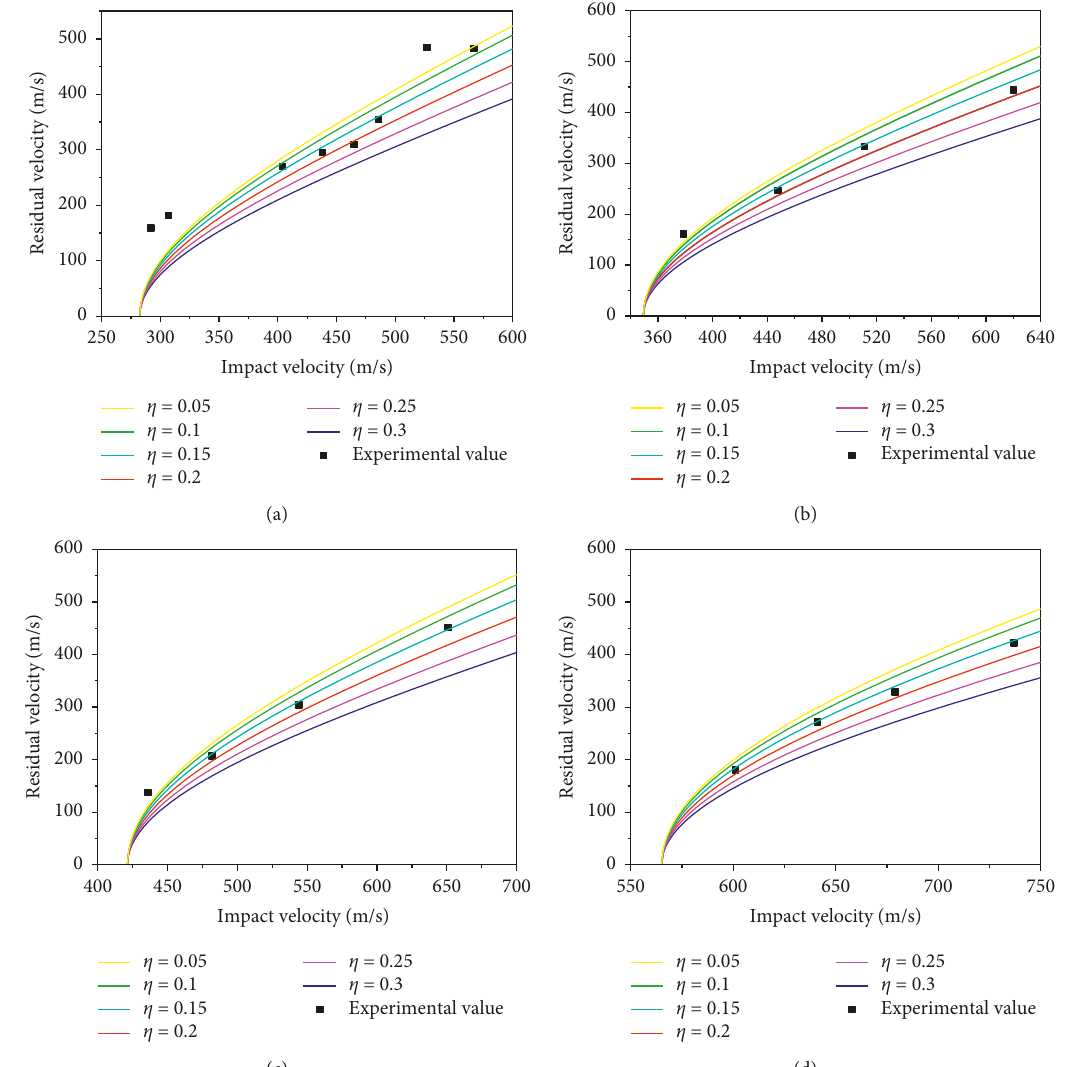
Figure 5: Comparison between calculated and experimental values of the projectile residual velocity for different concrete thicknesses. (a) 100mm. (b) 150mm. (c) 200mm. (d)